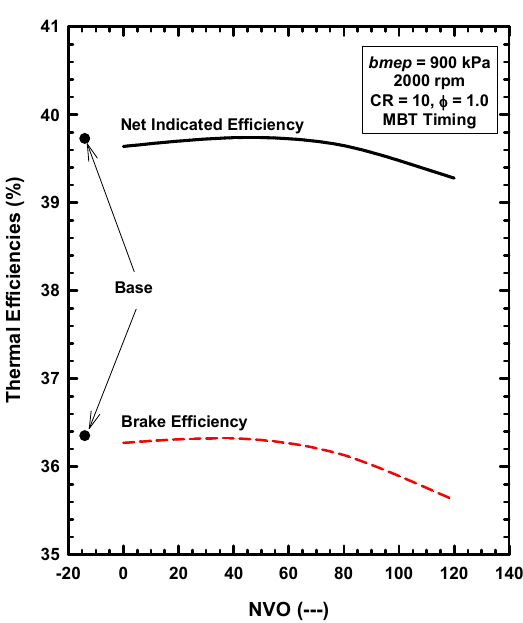
Figure 22. Net indicated and brake thermal efficiencies as functions of the negative valve overlap.